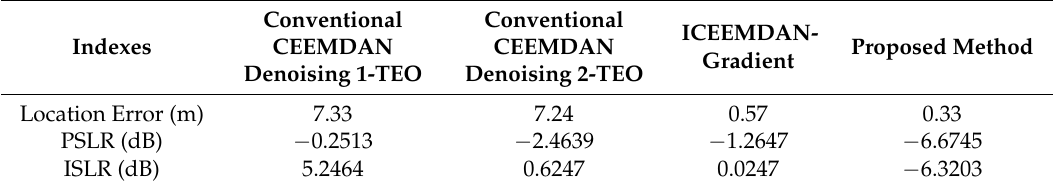
Table 4. The evaluation indexes of the four detection